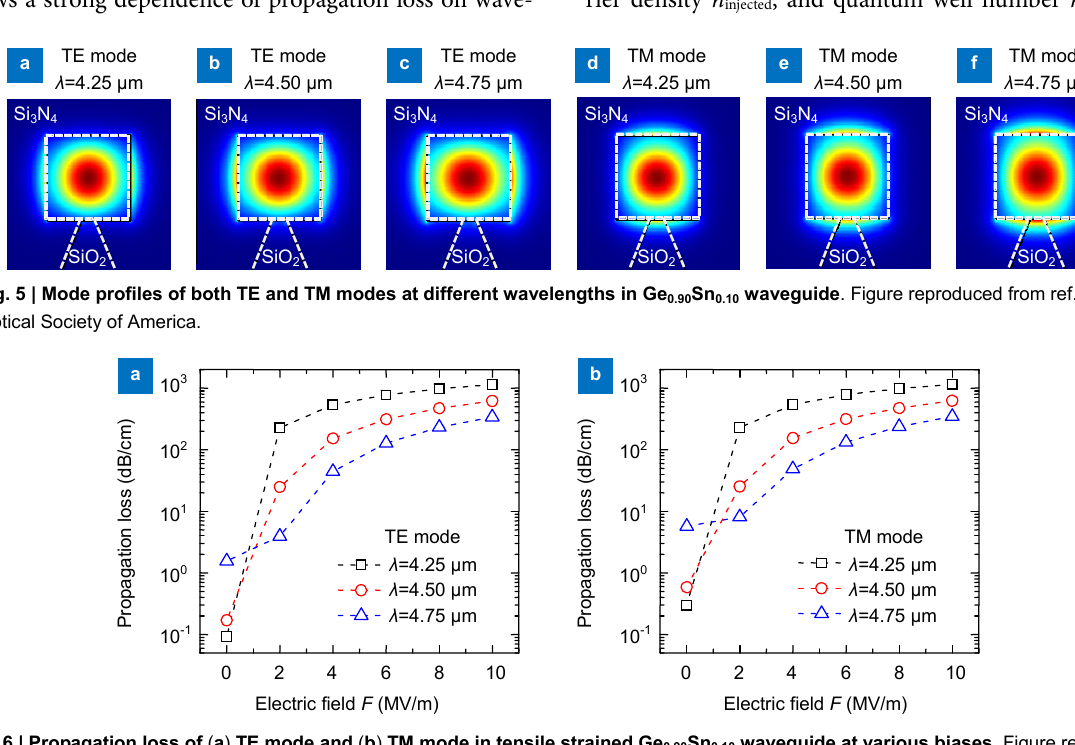
Fig. 6 | Propagation loss of ( a ) TE mode and ( b ) TM mode in tensile strained Ge 0.90 Sn 0.10 waveguide at various biases . Figure reproduced from ref. 26 , Optical Society of America.